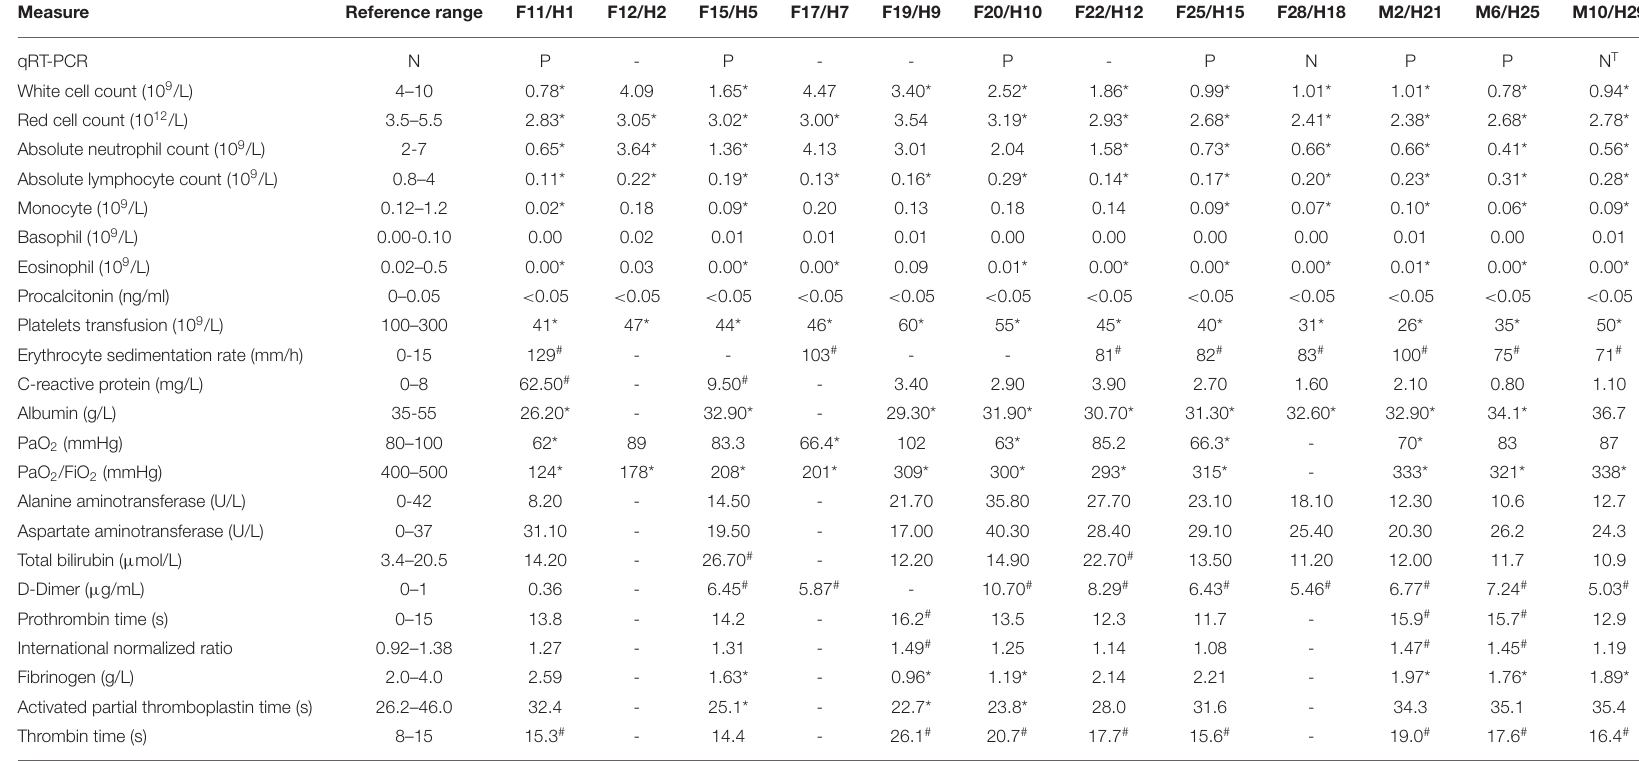
TABLE 1 | Clinical laboratory